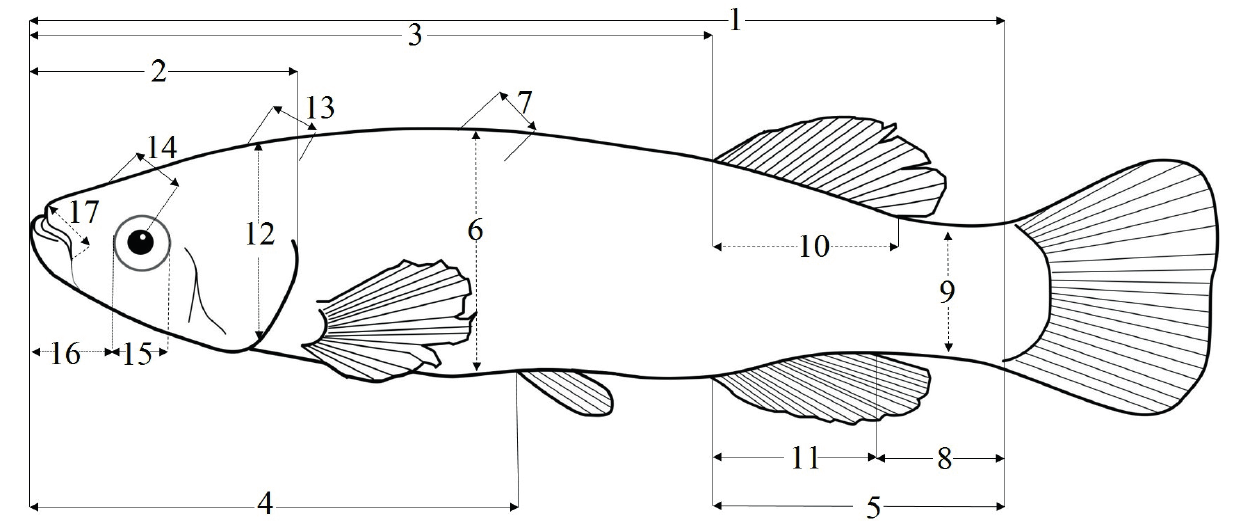
FIGURE 1 | Morphometric characters, based on sketches of Profundulus in lateral view. Morphometric measurements in the Material and Methods